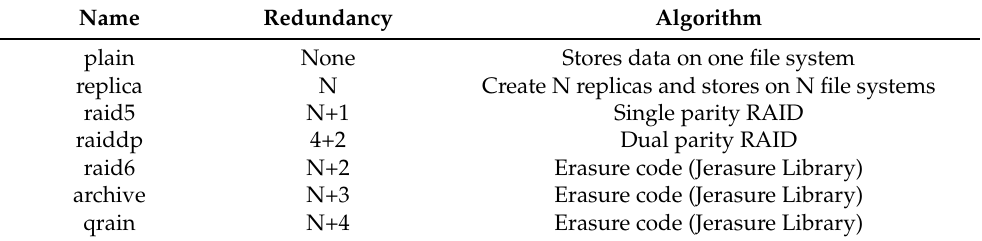
Table 1. EOS layouts [11].